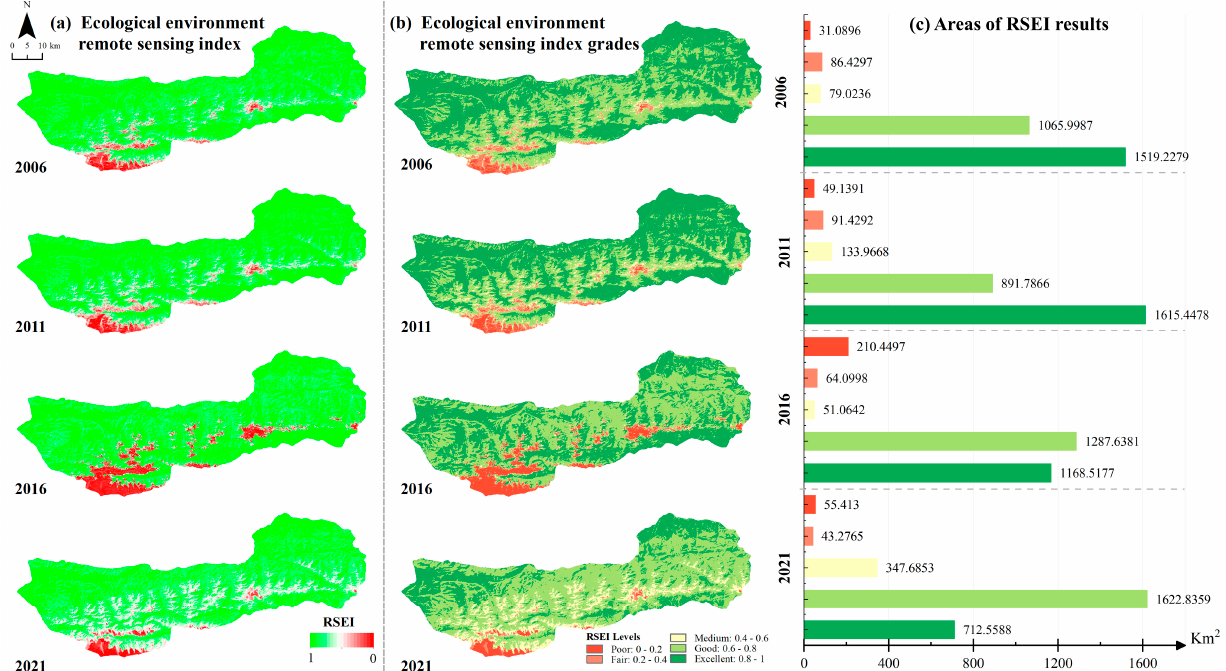
Figure 5. RSEI raw data and its classification results in 2006, 2011, 2016, 2021.